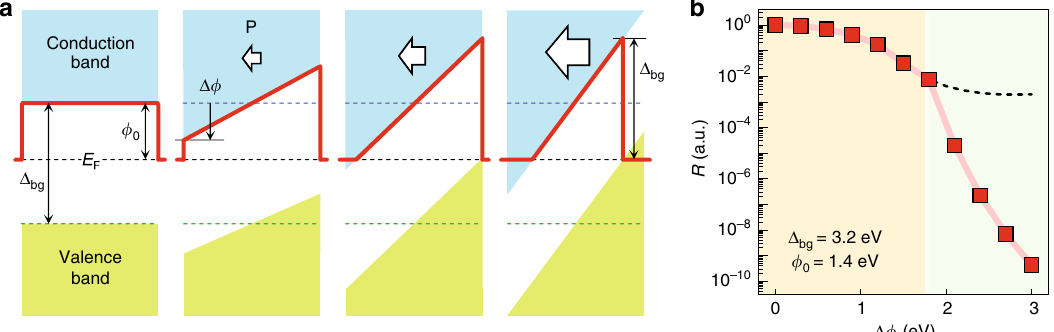
Fig. 1 Colossal decrease of resistivity in highly polarized ultrathin dielectrics. a Schematic diagram of the potential energy pro fi les across SrTiO 3 (STO) with increasing fl exoelectric polarization ( P ; white arrow). Red solid lines and black dashed lines indicate the effective tunnel barrier and Fermi level, respectively. Blue and green dashed lines indicate the conduction band minimum and valence band maximum for P = 0, respectively. b Resistance as a function of Δ φ , obtained by calculating tunneling conductance through a Wentzel – Kramers – Brillouin (WKB) approximation. We normalize the resistance by the value at Δ φ = 0, and assume the bandgap Δ bg , original barrier height φ 0 , and original barrier width d 0 to be 3.2 eV, 1.4 eV, and 3.9 nm, respectively. At Δ φ = 1.8 eV, the valence band maximum crosses the Fermi level, which causes an abrupt reduction in the resistance. The black dashed line indicates the result obtained by neglecting the valence band contribution. Source data are provided as a Source data fi